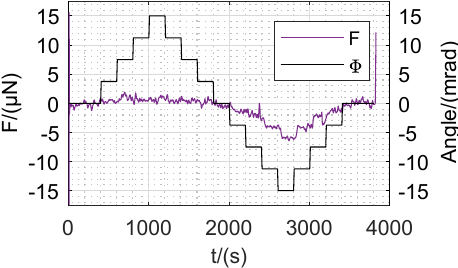
Figure 14. Influence of tilt on the weighing result.